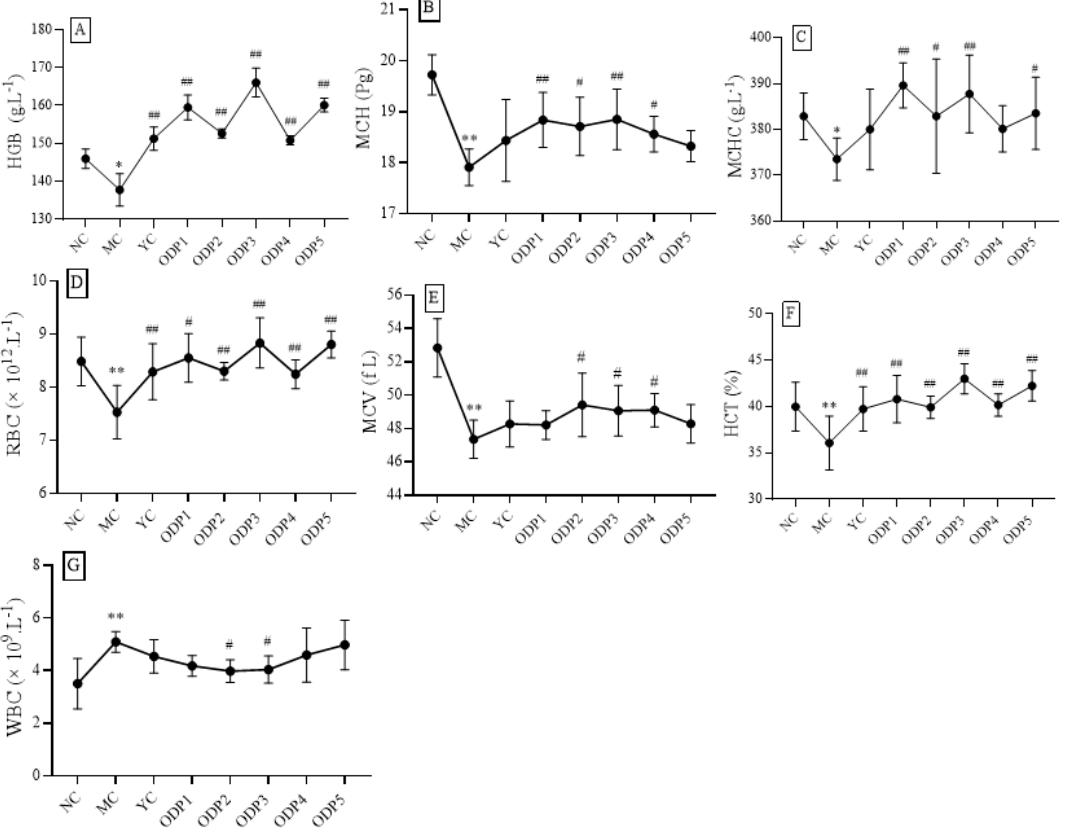
Figure 5. Dose–response relationship of ODP in mice peripheral blood: ( A – G ) are HGB, MCH, MCHC, RBCs, MCV, HCT, and WBCs, respectively. NC: normal control group, MC: CdCl 2 -treated group, YC: positive-treated group, ODP1–5: ODP (50, 100, 200, 400, 600 mg/kg)-treated group. The presented values are x ± SD ( n = 6 for each group). Compared with normal control group (NC group), # compared with model control group (MC group). * p < 0.05, ** p < 0.01; # p < 0.05, ## p < 0.01.